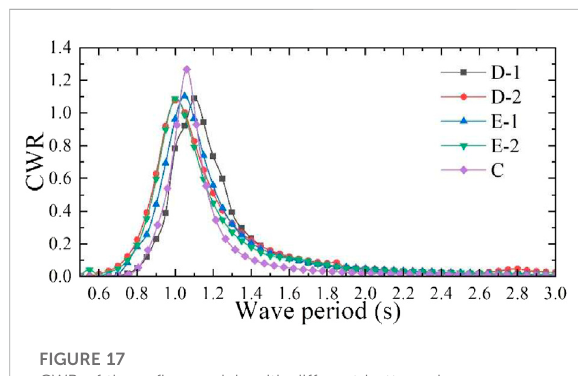
FIGURE 17 CWR of these fi ve models with different bottom